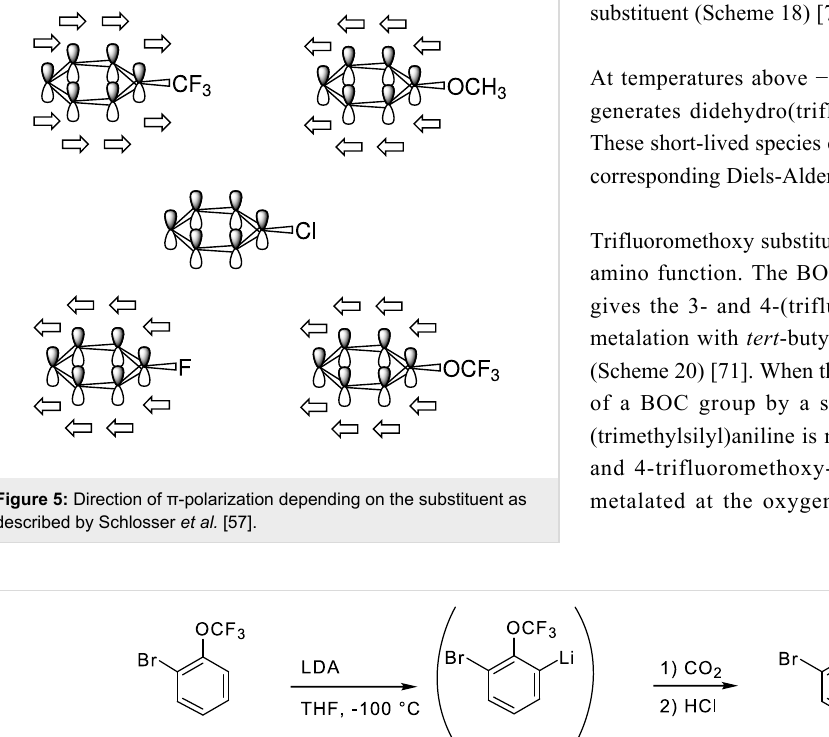
ortho position, 300 if in the para position and almost 2000 if in the meta position